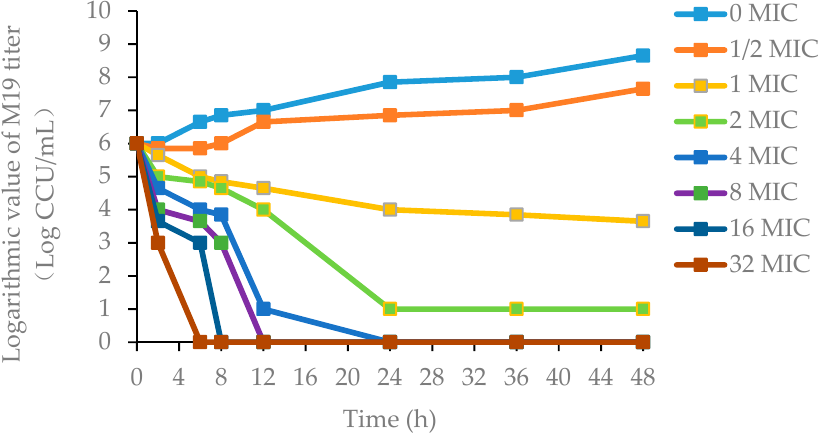
Figure 2. The killing-time curves of danofloxacin against M19 in FM-4 broth (in vitro). Note: M19 is a highly pathogenic strain as determined by the chicken embryo virulence test. FM-4 is a medium for the culture of MG . MIC (2 µ g/mL) is the minimum inhibitory concentration of danofloxacin against M19.